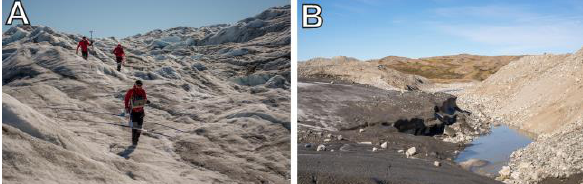
Figure 2. Survey environment and equipment. GPR during data gathering (A), A view towards the LIA end moraine that is divided in two parts due to meltwater erosion during outburst floods. Note the possible remnant of englacial tunnel in the middle of image